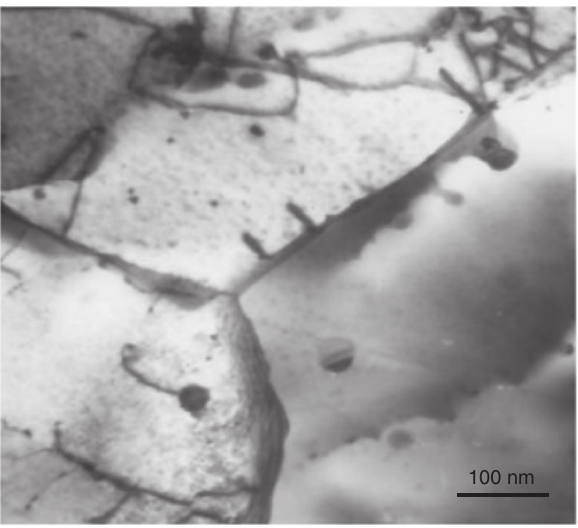
Figure 4: Morphology of the precipitates and dislocation in the copper